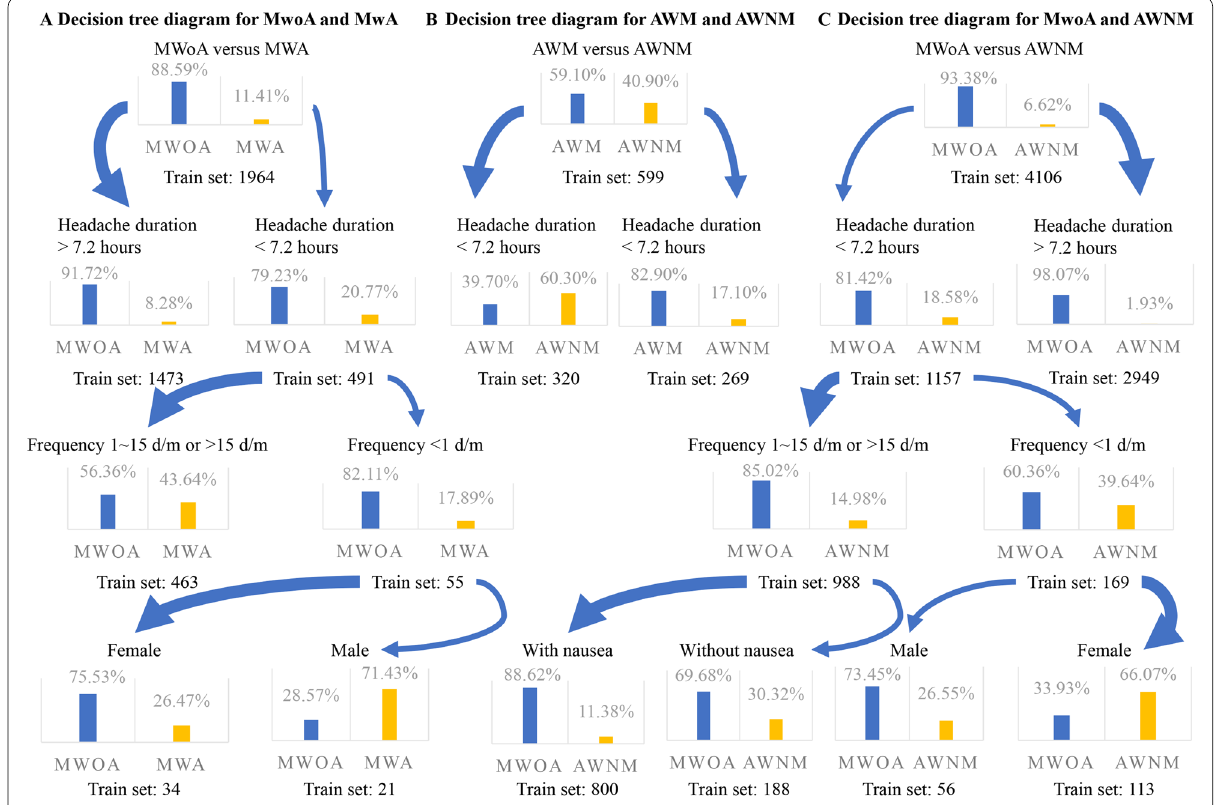
Fig. 8 Decision tree diagram for the distinguishing of migraine subtypes. In individuals with a headache lasting shorter than 7.2 h, the proportion of MwA in the training set increased to 20.77% from 11.41%. Among them, patients who experienced headaches more than once a month had a 43.64% chance of developing MwA ( A ). The only variable that ultimately distinguished AWM and AWNM was the duration of headache. In patients with a headache duration shorter than 7.2 h, the proportion of AWNM patients in the training set grew from 40.90–60.30%, while AWNM patients accounted for only 17.10% in patients with a headache duration longer than 7.2 h ( B ). For distinguishing MwoA from AWNM, the variables were duration of headache, frequency, and whether it was accompanied by nausea. The proportion of AWNM patients in the training set boosted from 6.62–18.58% in patients with headaches lasting less than 7.2 h, while AWNM patients accounted for only 1.93% in patients with headaches lasting more than 7.2 h. If the frequency of headaches was less than 1 day/month, the proportion of AWNM patients increased to 39.64%. There was an 88.62% probability of MwoA in patients with headache duration less than 7.2 h, headache frequency greater than 1 day/month, and accompanied with nausea ( C ). d/m: